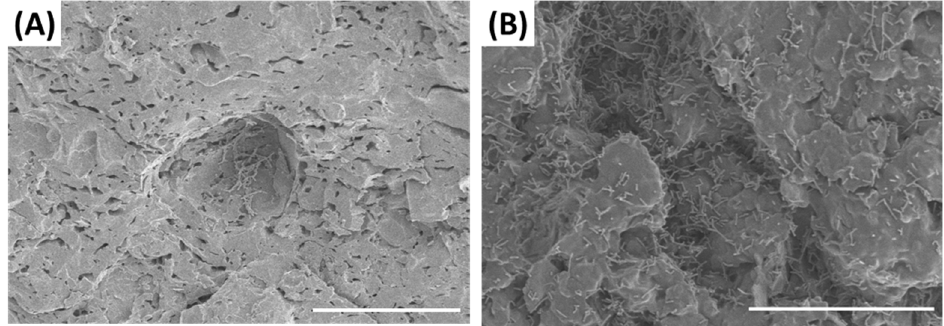
Figure 4. Observation of the surface of PSs (#1 and #13) with addition of strain GYP-74 with a scanning electron microscope (scale bar, 50 µm). ( A ) #1, ( B ) #13. scanning electron microscope (scale bar, 50 µ m). ( A ) #1, ( B )